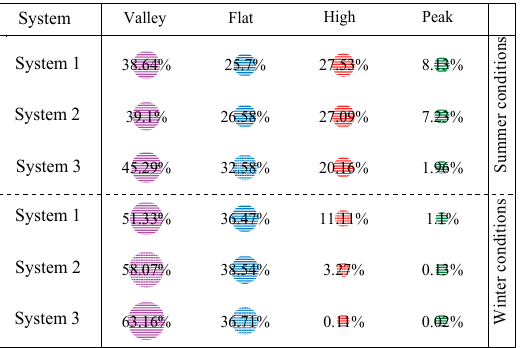
Figure 13. The ratio of grid power consumption under the TOU power price.